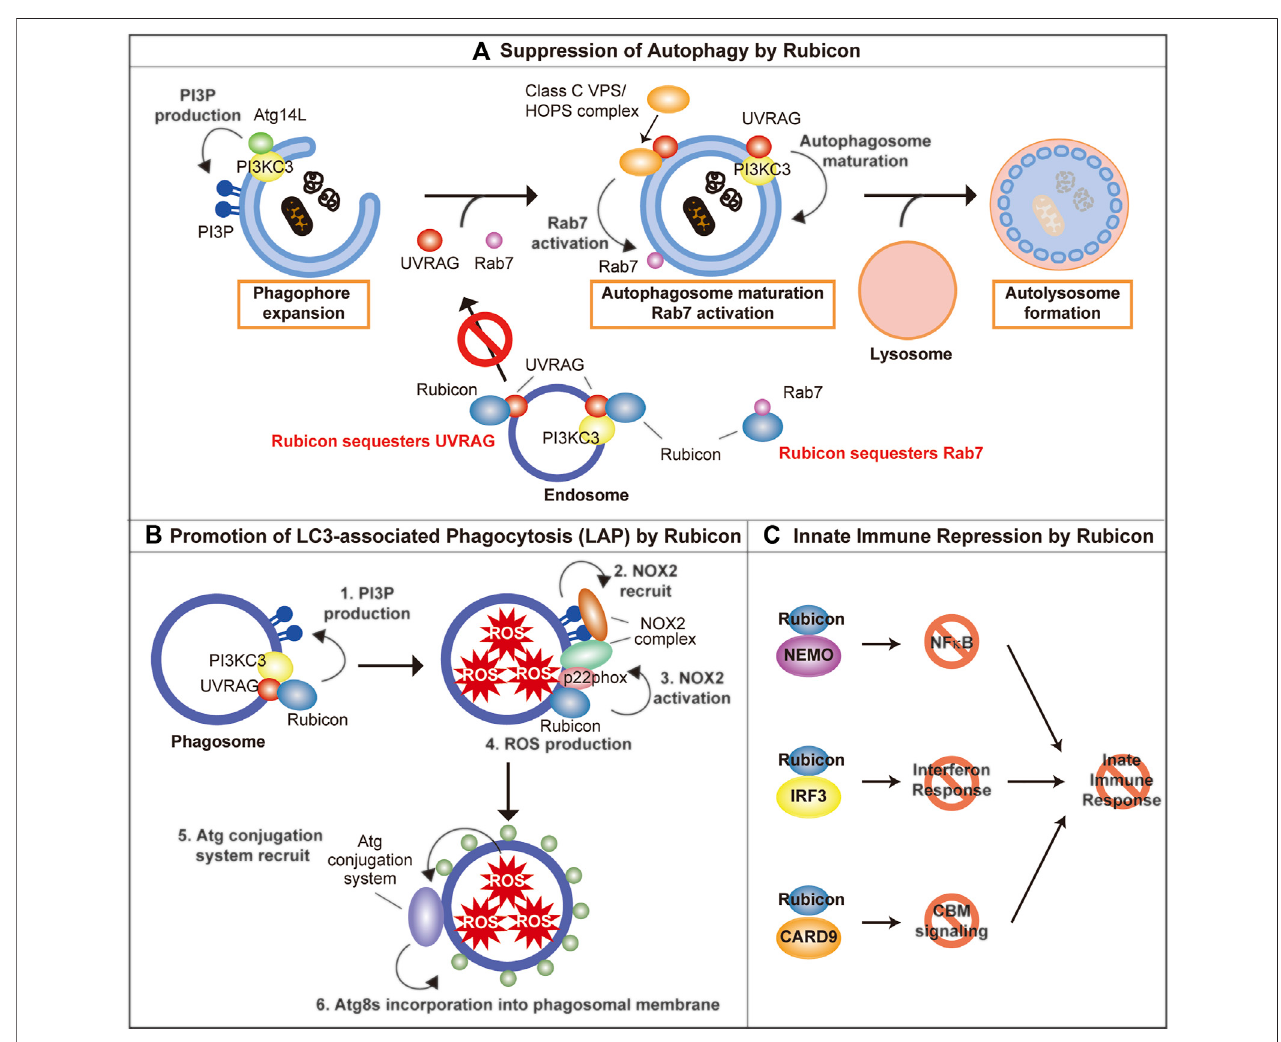
FIGURE 1 | The molecular function of Rubicon. (A) Rubicon suppresses autophagosome maturation via the sequestration of UVRAG, PI3KC3, and Rab7. (B) Rubicon promotes LAP via promotion of PI3P production and stabilization of NOX2 complex on phagosomes. (C) Rubicon inhibits innate immune response via the sequestration of NEMO, IRF3, and CARD9. PI3P, phosphatidylinositol-3-phosphate; PI3KC3, Class III phosphatidylinositol-3-kinase; NEMO, NF- κ B essential modulator; IRF3, interferon regulatory factor 3; CARD9, caspase recruitment domain-containing protein 9.